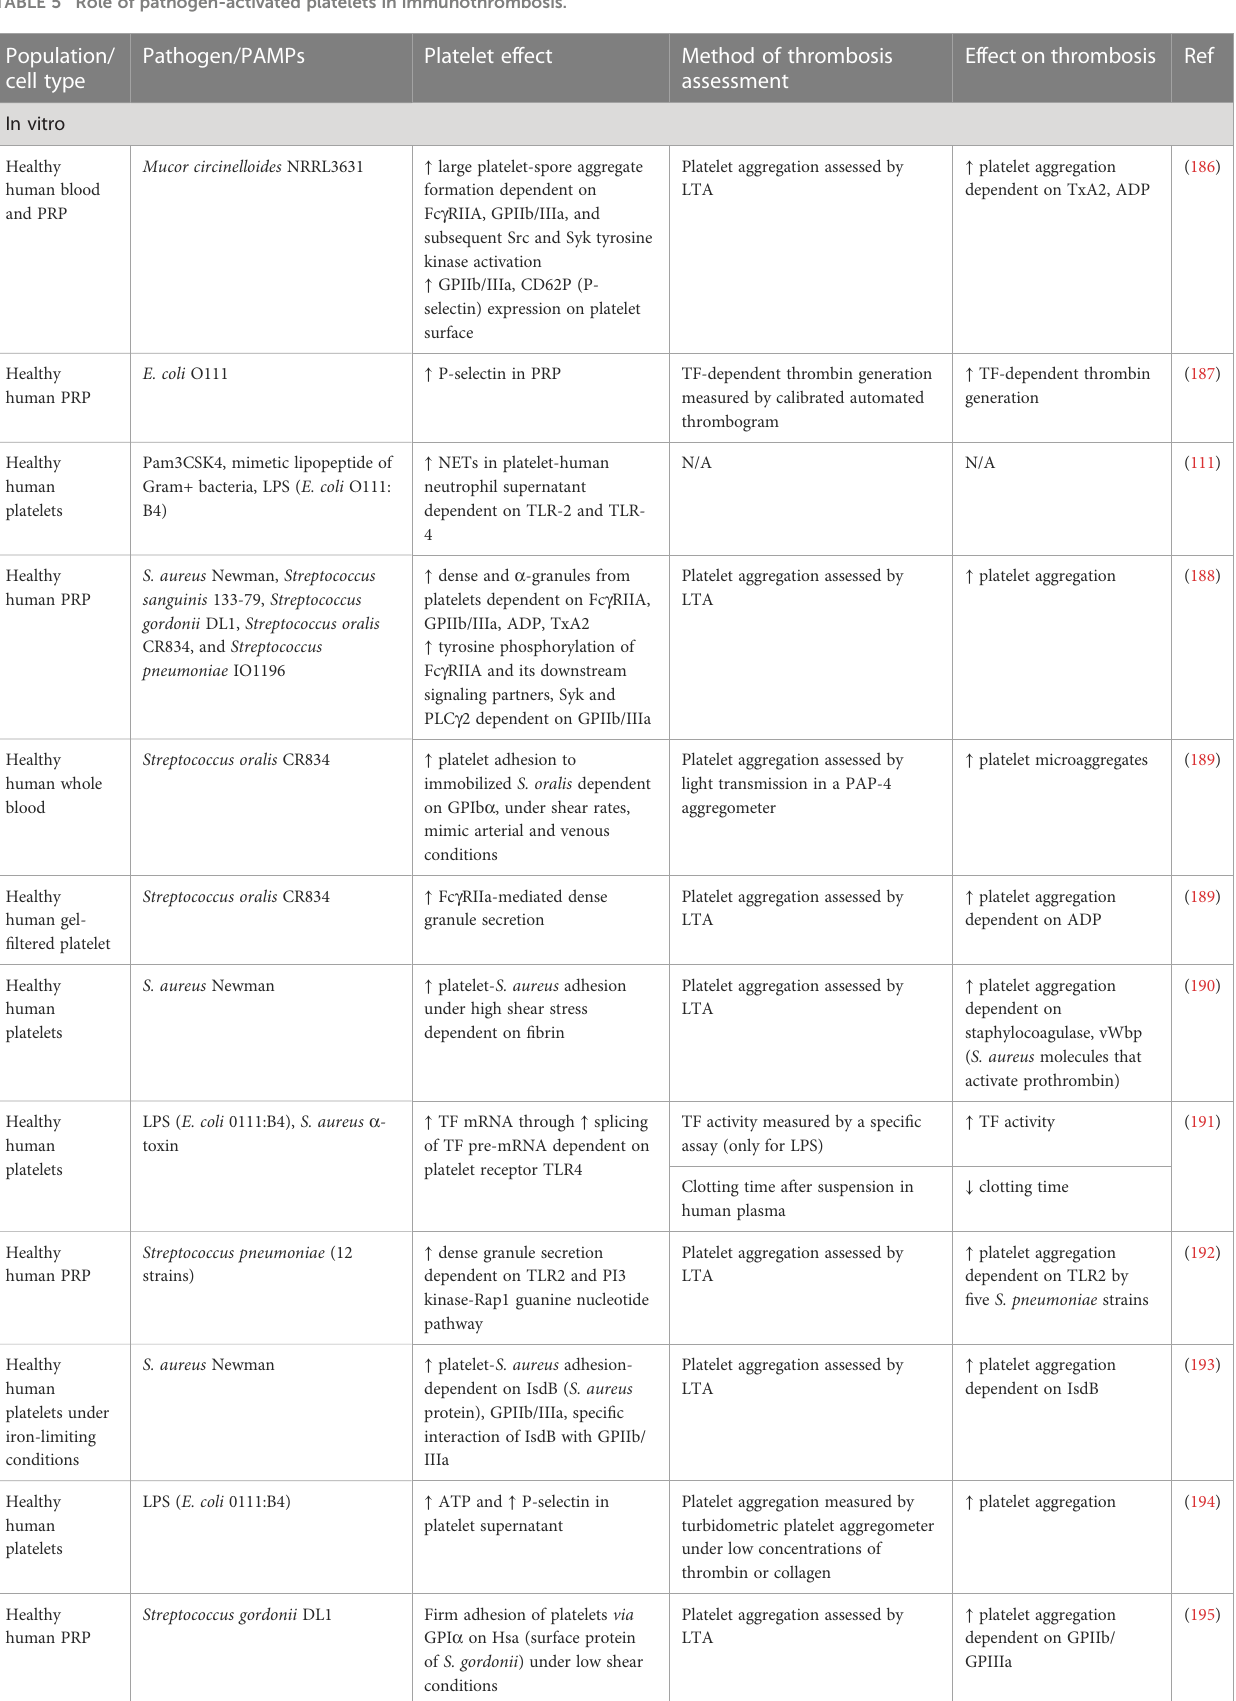
TABLE 5 Role of pathogen-activated platelets in